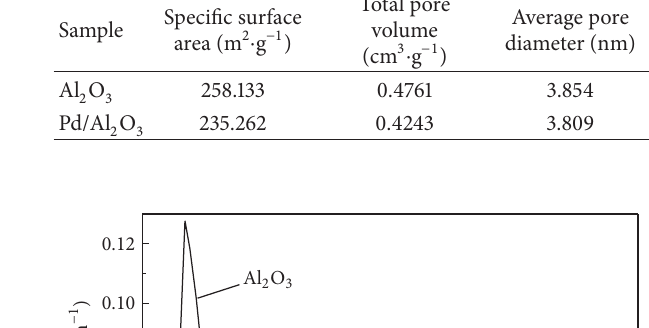
Figure 10: The XPS spectra of 1% Pd/Al 2 O 3 before and after reaction. (a) 1% Pd/Al 2 O 3 ; (b) 1% Pd/Al 2 O 3 after reaction.